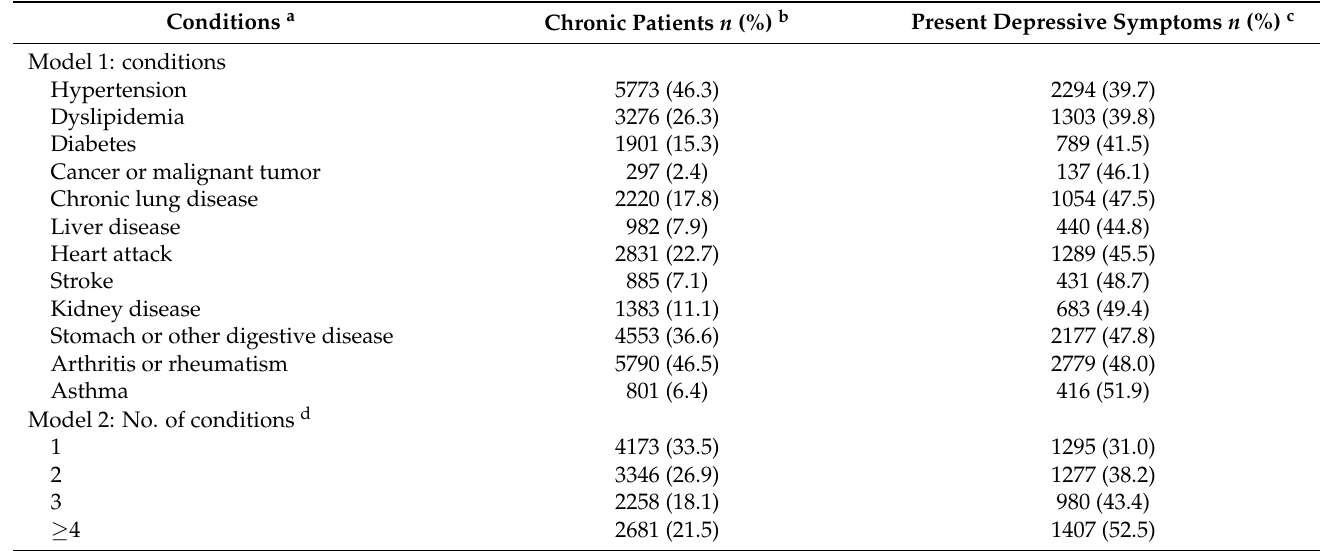
Table A1. Characteristics of chronic patients and prevalence of depressive symptoms from CHARLS survey in 2018 ( n = 12,458).